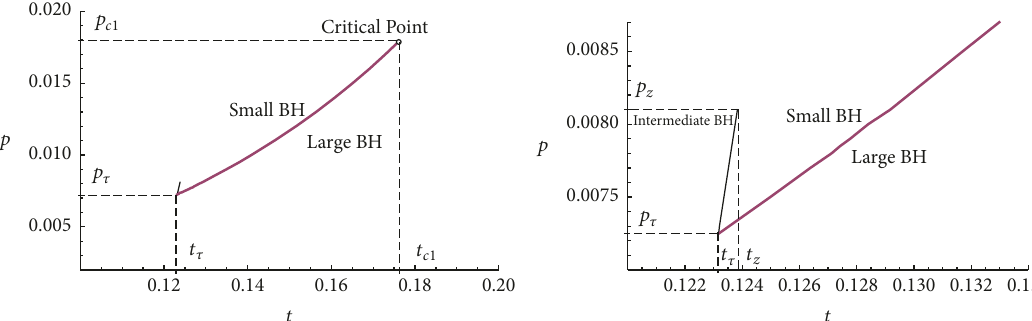
Figure 3: The coexistence line of the VdW-like SBH/LBH phase transition is depicted by a thick solid line. It initiates from the critical point (𝑝 , 𝑡 ) and terminates at (𝑝 ,𝑡 ) . The solid line describes the “coexistence line” of small and intermediate black holes, separated by a finite 𝑐1 𝑐1 𝜏 𝜏 gap in 𝑔 , indicating the zeroth-order phase transition. It commences from (𝑡 𝑧 , 𝑝 𝑧 ) and terminates at (𝑝 𝜏 , 𝑡 𝜏 ) .